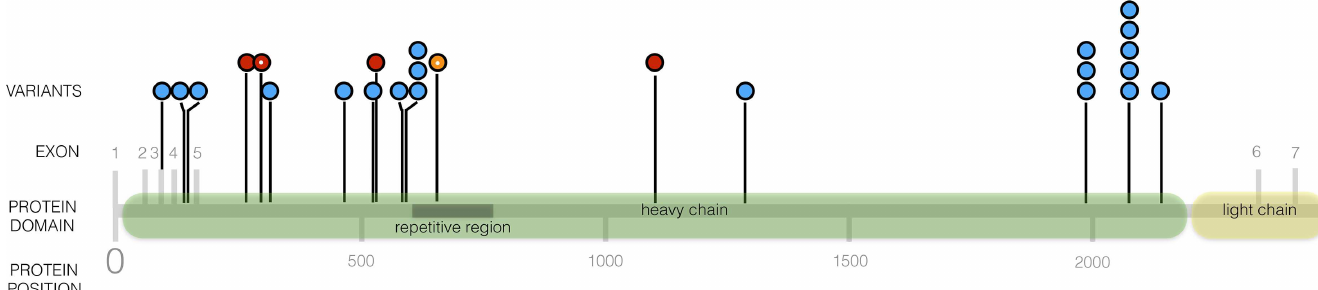
Fig 2. Distribution of MAP1B LOF alleles in PVNH cases (red dots), in individuals from ExAC and gnomAD databases (blue dots with number of alleles observed represented by number of dots running vertically at this site), and in the Deciphering Developmental Disorders case (orange dot). A Sanger confirmed de novo variant is indicated with a white dot in the